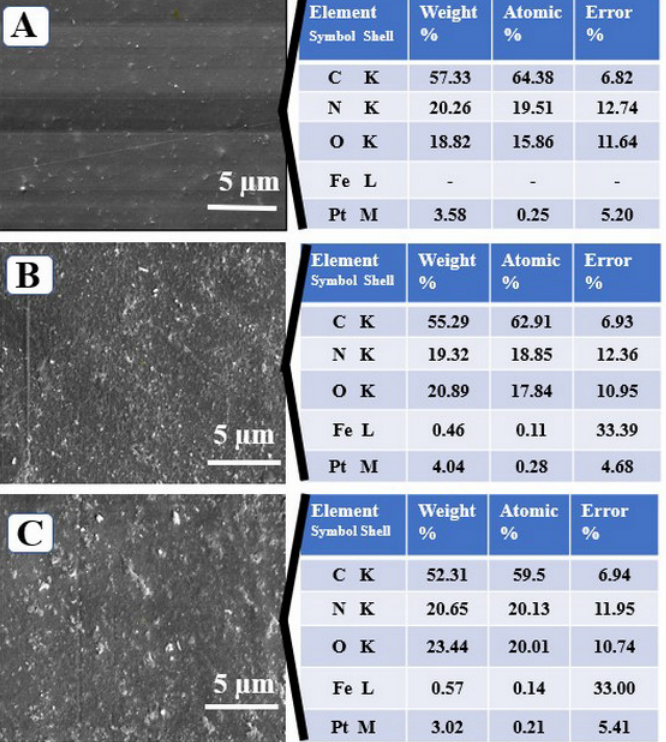
Figure 4. SEM micrographs of the G-material ( A ) and G-material with nanoparticles G–Fe 2 O 3 ( B ) G–Fe 3 O 4 ( C ) and their elemental composition. Table 1. Surface tension parameters of gelatin-based materials with and without iron oxide nanoparticles. Contact Samples